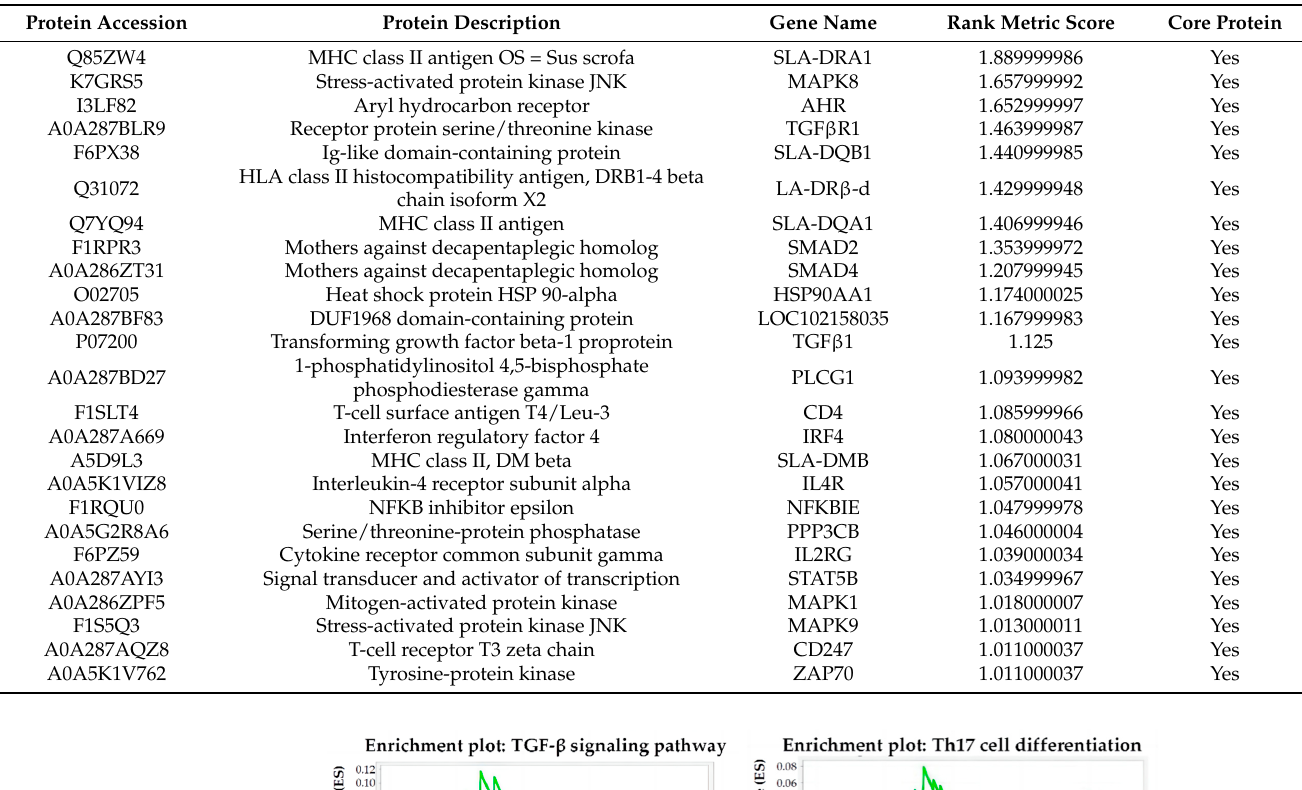
Table 2. Core proteins that inhibited the differentiation of Th17 cells.